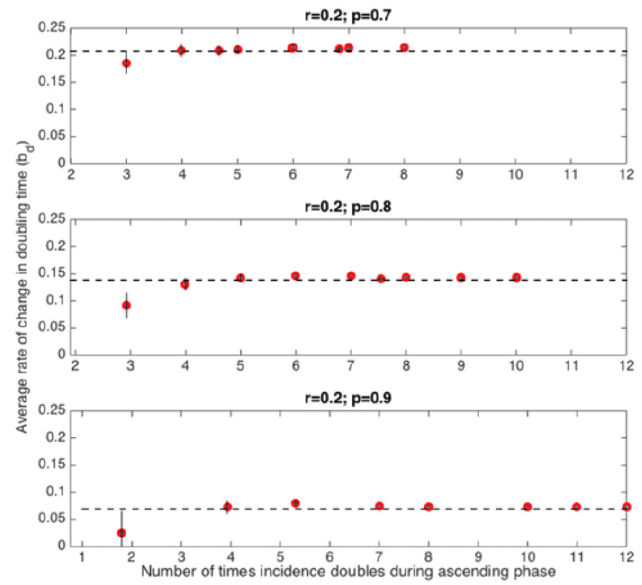
Figure 4. Assessing our ability to estimate b d when limited simulated data includes a Poisson error structure as described above. Findings indicate that the parameter b d can be reliably estimated from the first few doubling times of the